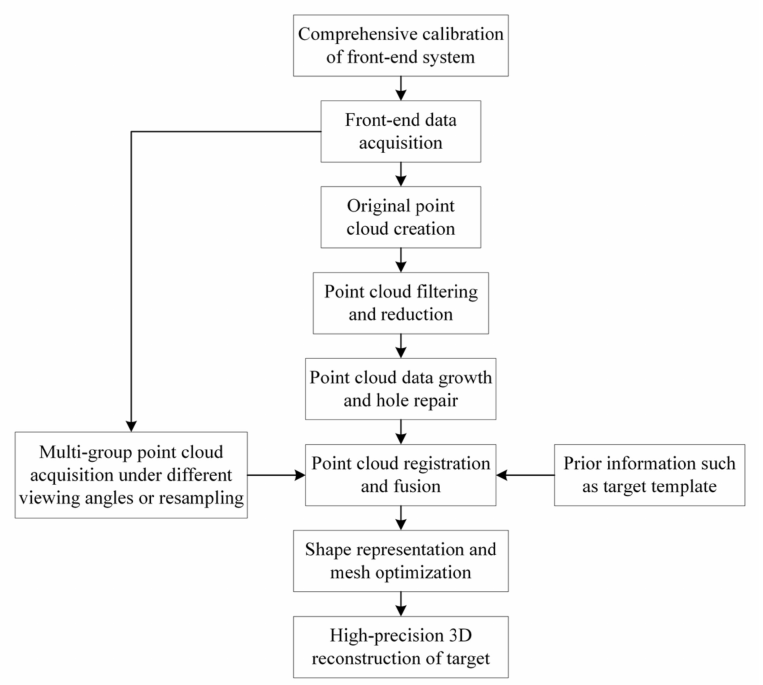
Figure 3. Schematic diagram of the light-section 3D reconstruction technology based on single-line- structured